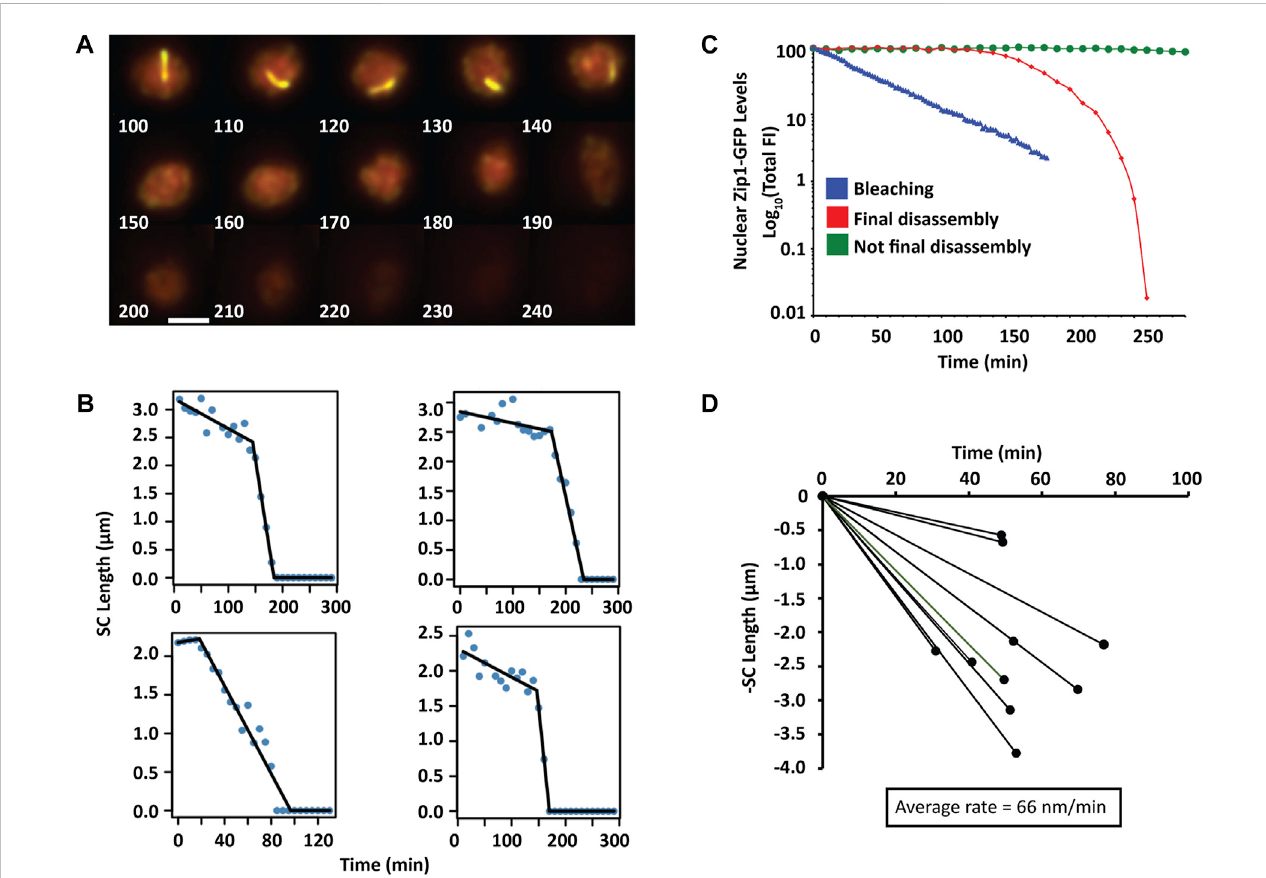
Final SC disassembly (A) A time series of 2D max-sum projections at 10-minute intervals from 3D image stacks of a single zip3 Δ nucleus with a single chromosome undergoing fi nal synapsis disassembly visualized by Zip1-GFP. Scale bar — 2 µm. (B) Four representative nuclei containing one chromosome for whichSClengthwasmeasuredasafunctionoftimeduringthe fi naldisassemblyoftheSC. (C) ComparisonofnuclearZip1-GFP fl uorescencelevelswhenSCs are all disassembling (red diamonds), not at fi nal disassembly (green circles), not disassembling but subjected to heavy bleaching conditions (blue triangles). Log plots are normalized to the respective maximum intensity. (D) Disassembly of SC is monophasic. The rate and length of each SC disassembly is plotted ( n =